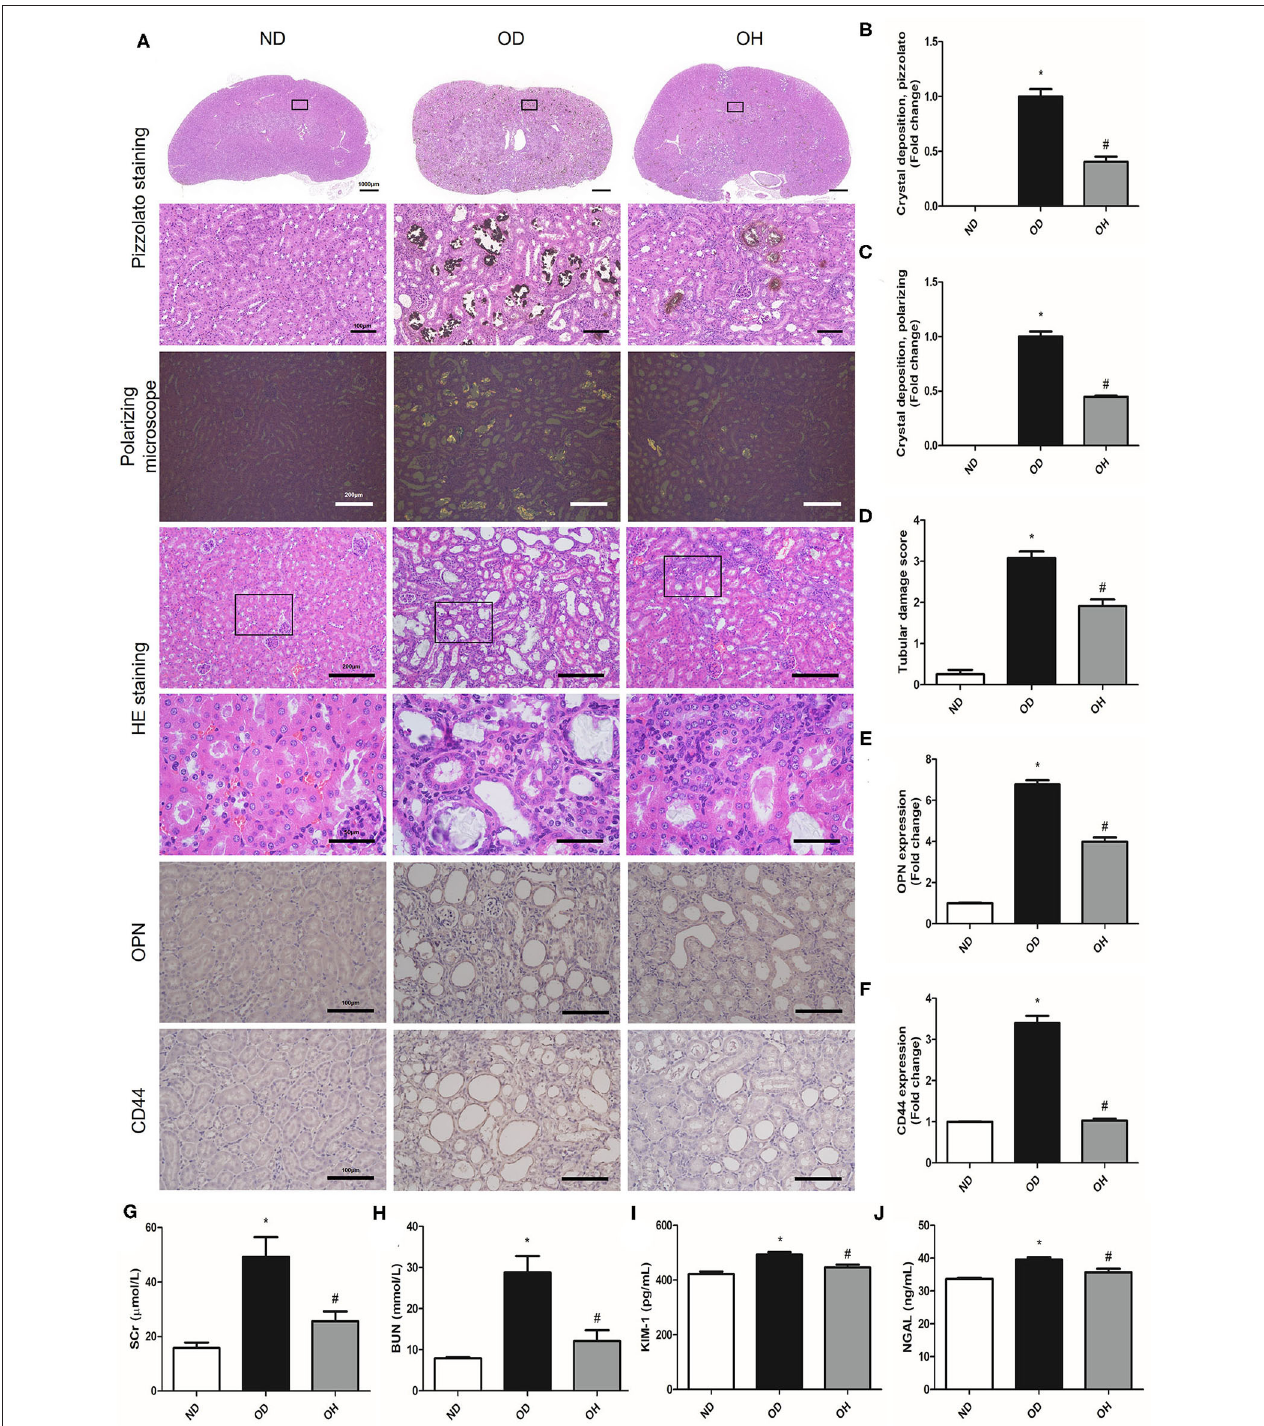
FIGURE 1 | HRW administration ameliorates oxalate-induced crystal deposition and renal injury in mice. (A) The CaOx crystal deposition in kidneys of mice was detected by pizzolato staining (Scale bar = 1,000 and 100 µ m) and polarization microscopy (Scale bar = 200 µ m); The renal histological changes in mice were observed by HE staining (Scale bar = 200 and 50 µ m); The protein expressions of OPN and CD44 in kidneys of mice were detected by immunohistochemistry (Scale bar = 100 µ m). (B–F) Corresponding semiquantitative analysis of pizzolato staining, polarization microscopy, HE staining and OPN and CD44 immunohistochemistry staining. (G–J) The levels of SCr, BUN, KIM-1, and NGAL in serum of mice were determined by corresponding kits. The results were expressed as mean ± SEM. Statistical comparisons were performed using a NewmanKeuls test (* p < 0.05 vs. ND group, # p < 0.05 vs. OD group).